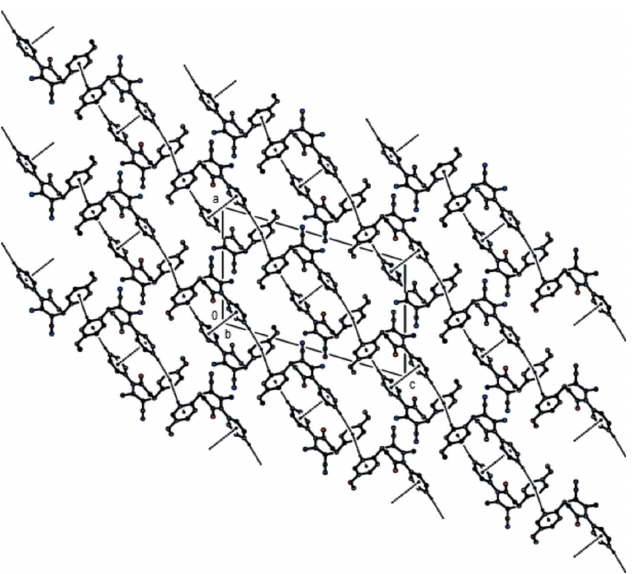
Figure 5 The crystal packing of the title compound, viewed along the b axis, showing the C—H (cid:2)(cid:2)(cid:2) (cid:2) interactions and (cid:2) – (cid:2) stacking interactions as dashed lines.